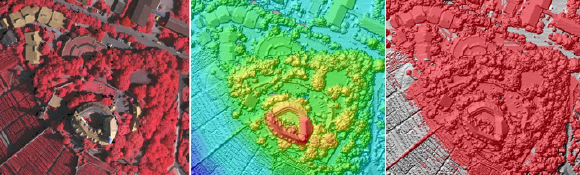
Figure 9. A problematic area in the Vaihingen scene. Left to right: CIR orthophoto, hill shaded DSM, elevated mask. Instead of separating the castle and trees on the hill from the ground, the whole hill is detected as one single